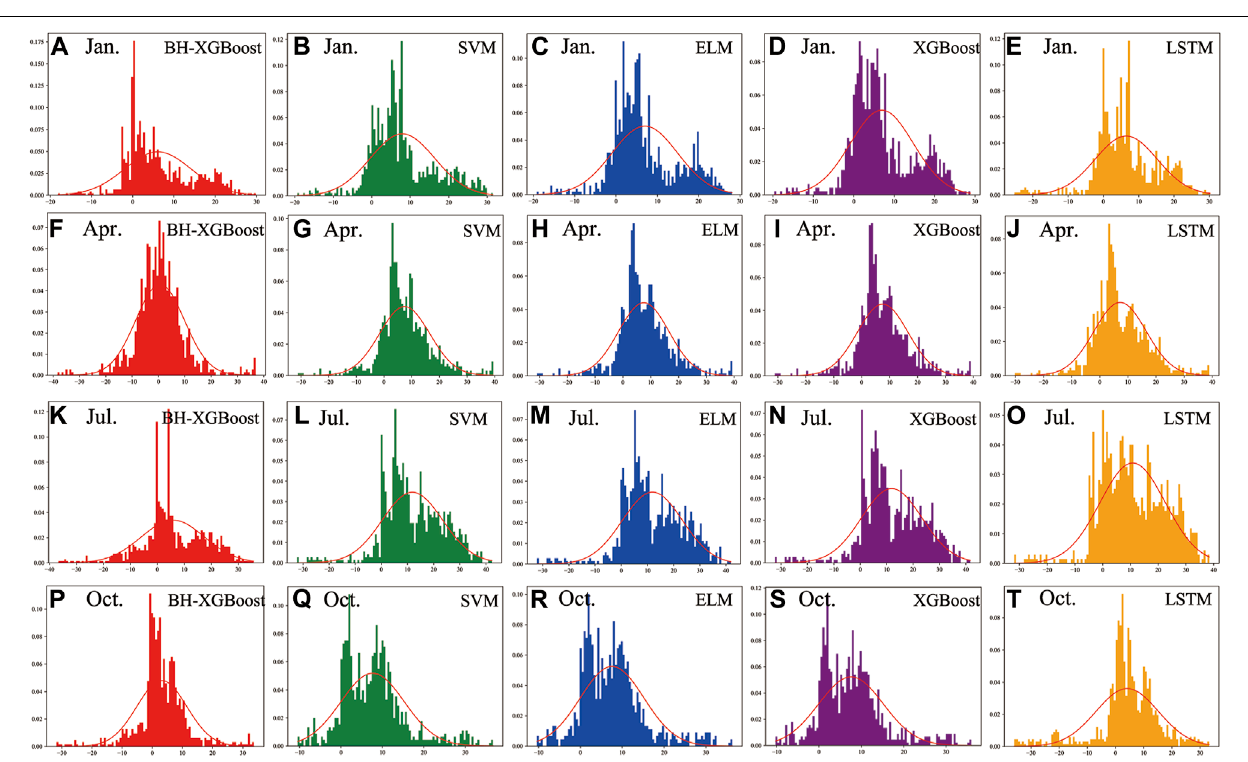
Frontiers in Energy Research |